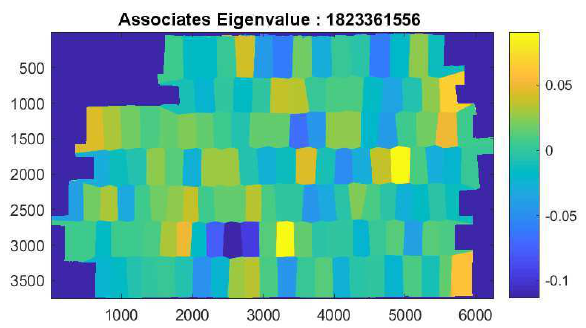
Figure 7d: Correlation with the fourth KLT axis (local mean)